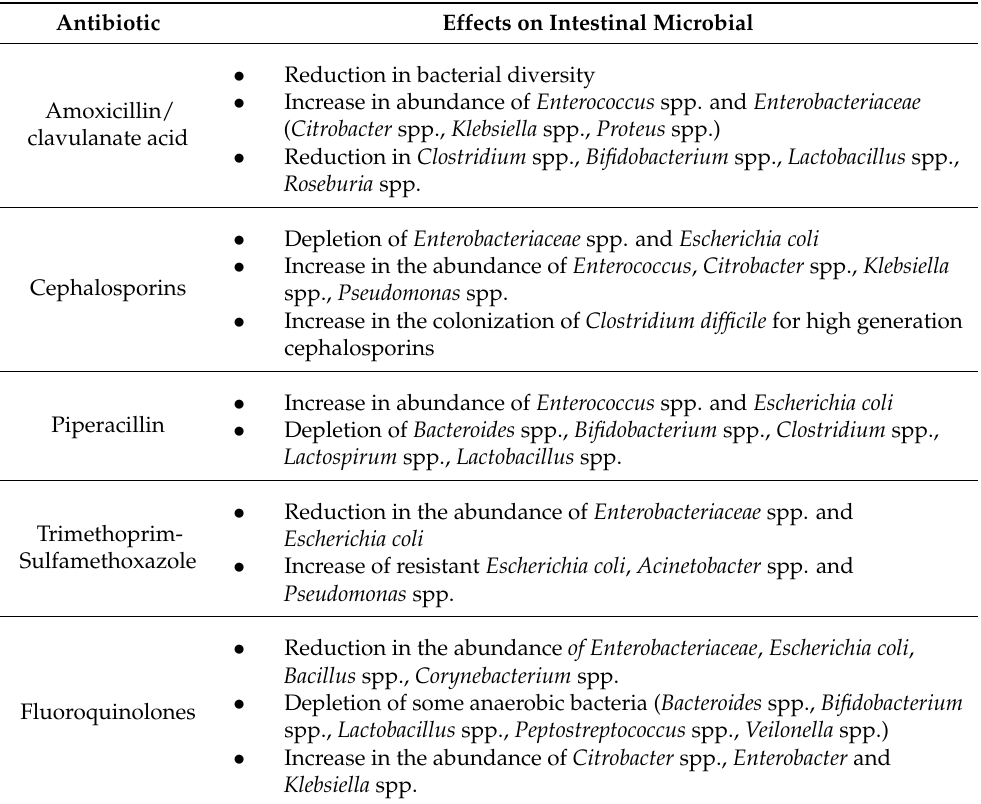
Table 3. Effects of different antibiotics on intestinal